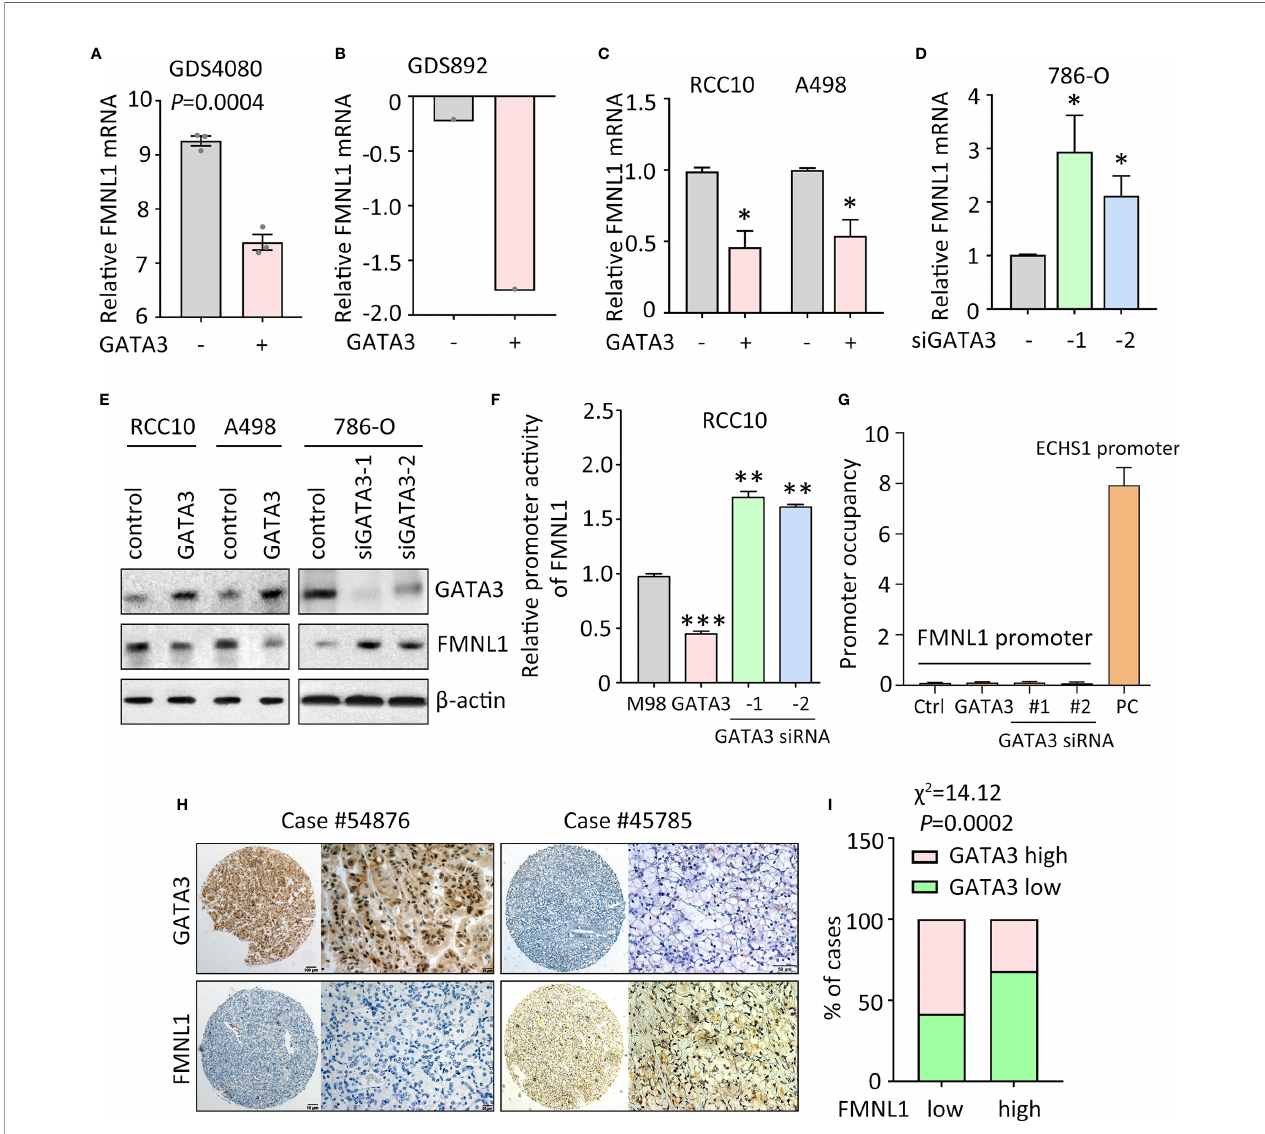
FIGURE 2 | FMNL1 is regulated by GATA3 in ccRCC cells. (A) The expression of FMNL1 was determined in breast cancer MDA-MB-231 cells. Data were from a GEO study (no. GDS4080). (B) 293T cells were transfected with GATA3. The mRNA expression of FMNL1 was examined. Data were from another GEO study (no. GDS892). (C) RCC10 and A498 cells were transfected with GATA3 overexpression vectors for 36 h. The expression of FMNL1 mRNA was examined by qRT-PCR. * P < 0.05. (D) FMNL1 mRNA levels in 786-O cells transfected with GATA3 siRNAs for 36 h were measured. * P < 0.05. (E) The protein expression of GATA3 and FMNL1 in ccRCC cells with GATA3 overexpression or knockdown was examined by western blot. (F) Dual luciferase reporter assays were performed to indicate the effect of GATA3 on the activity of FMNL1 promoter. ** P < 0.01, *** P < 0.001. (G) ChIP assays were used to detect the enrichment of GATA3 on FMNL1 promoter. The binding of GATA3 onto ECHS1 promoter was used as positive control (PC). (H) GATA3 expression was further examined in 306 ccRCC paraf fi n-embedded tissues. A ccRCC case with low expression of FMNL1 showed high GATA3 expression. (I) The correlation of GATA3 and FMNL1 expression was determined by Pearson correlation analyses in 306 ccRCC